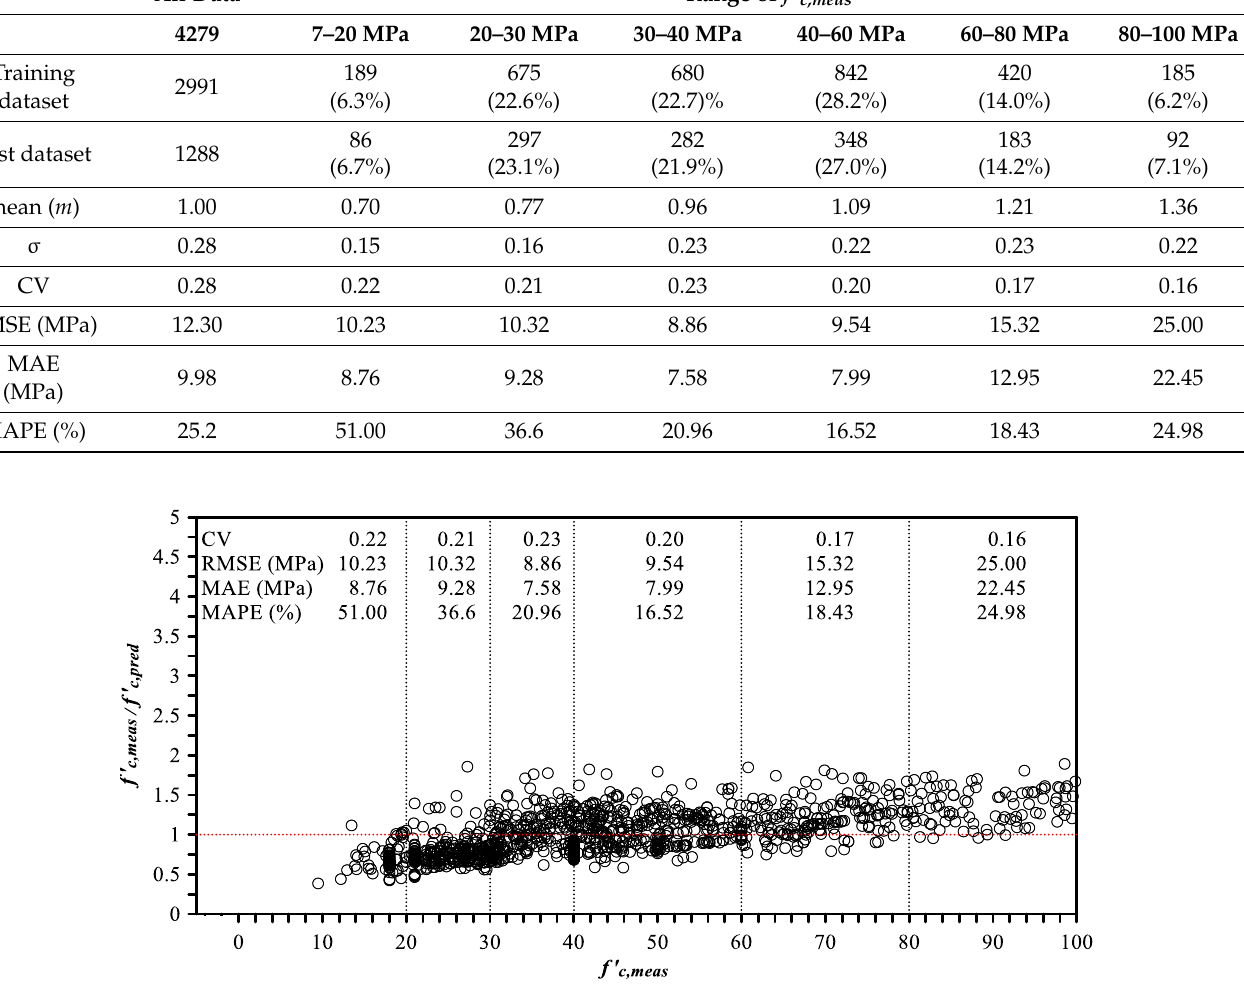
Figure 3. Relationship between γ obtained from Case-1 and f (cid:48) c,meas